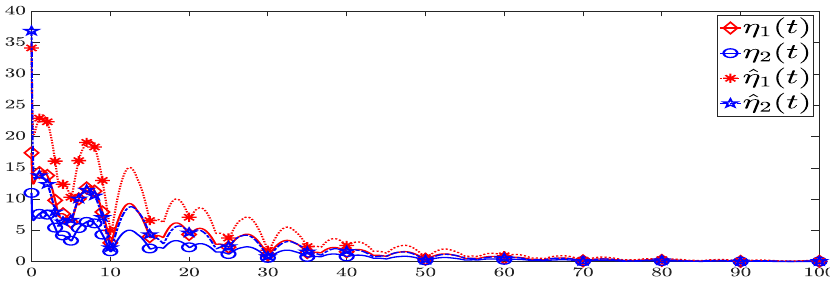
Figure 5. The state trajectories of system (1).